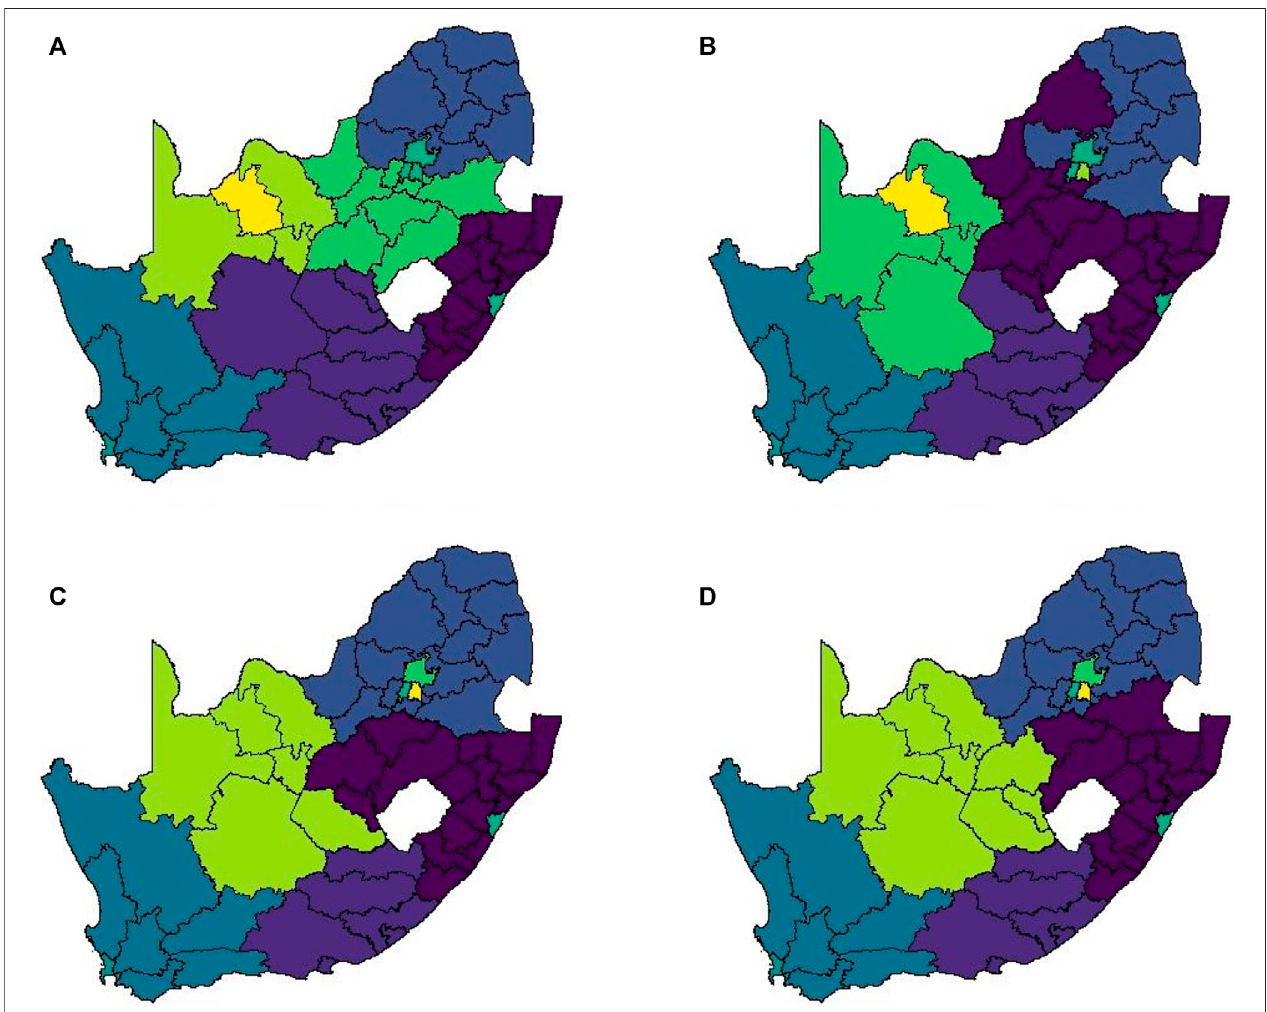
FIGURE 10 | Method 3 complete linkage clustering results (9 clusters) (A) Business as usual, (B) Level 5, (C) Level 4, and (D) Level 3.